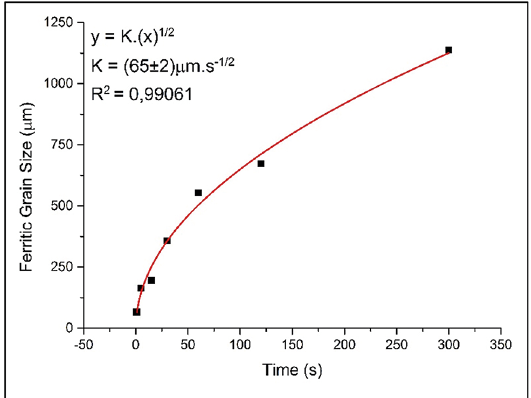
Figure 9. Ferrite grain size versus residence time at 1300°C for UNS S32304 stainless steel.